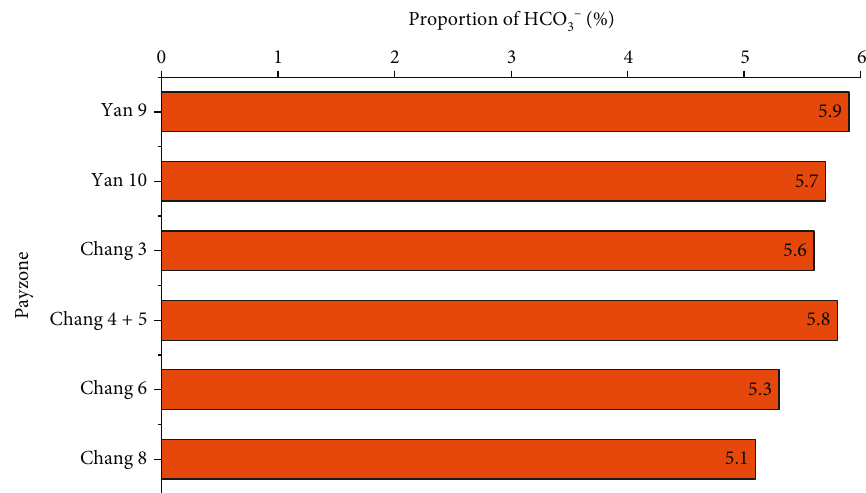
Figure 10: Proportion of HCO